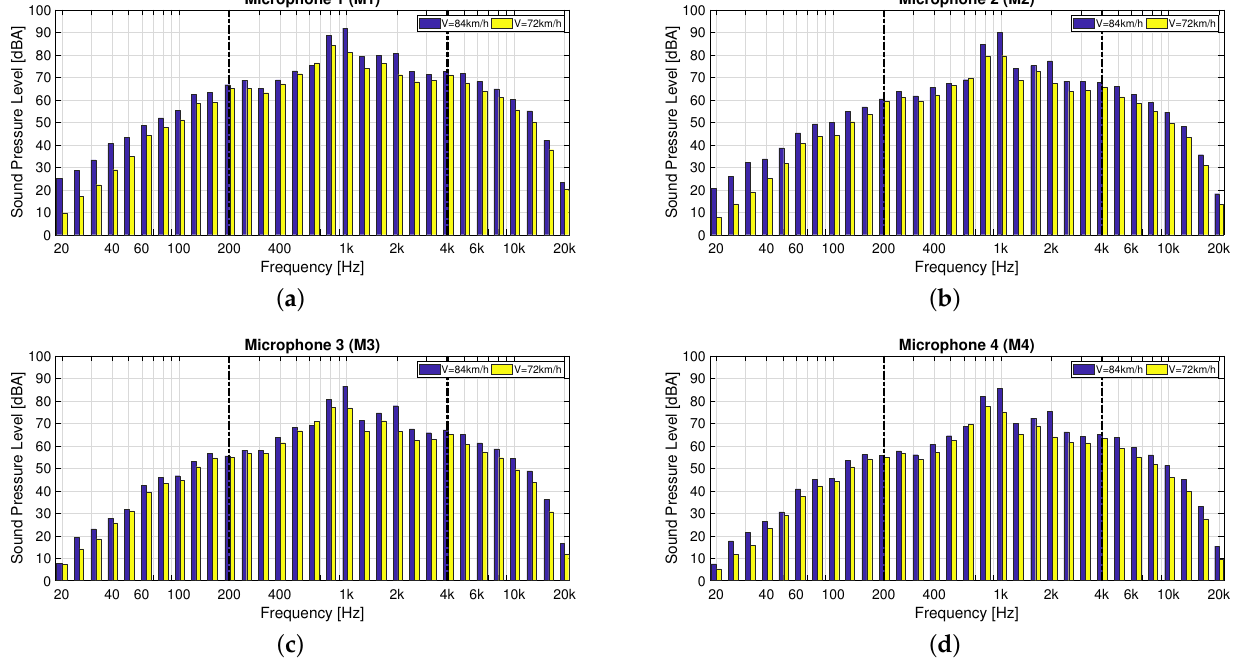
Figure 5. Records of measured sound pressure levels; in blue a vehicle operating at 84 km/h; in yellow a vehicle operating at 72 km/h. ( a ) First microphone; ( b ) Second microphone; ( c ) Third microphone; ( d ) Fourth microphone.